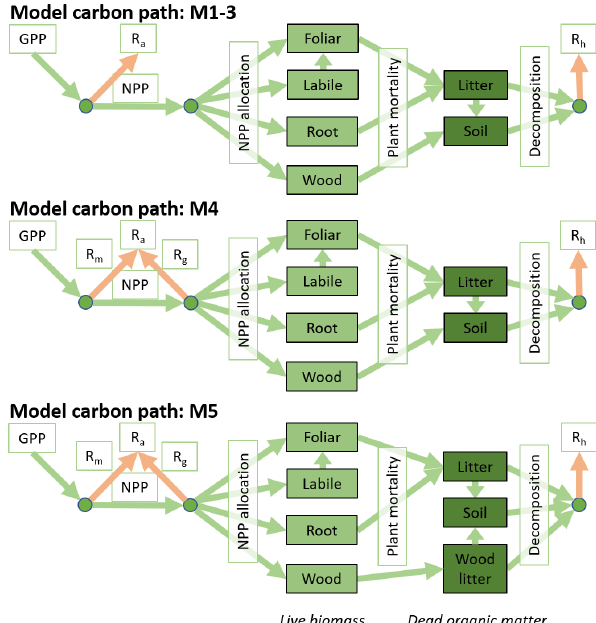
Figure 2. The five DALEC versions include three carbon cycle structures. The top row shows the DALEC model carbon structure as previously described in Bloom and Williams (2015) as is used for M1–3. The middle row shows M4 where R a is partitioned between R m and R g . The bottom row shows the inclusions of a wood litter pool used in